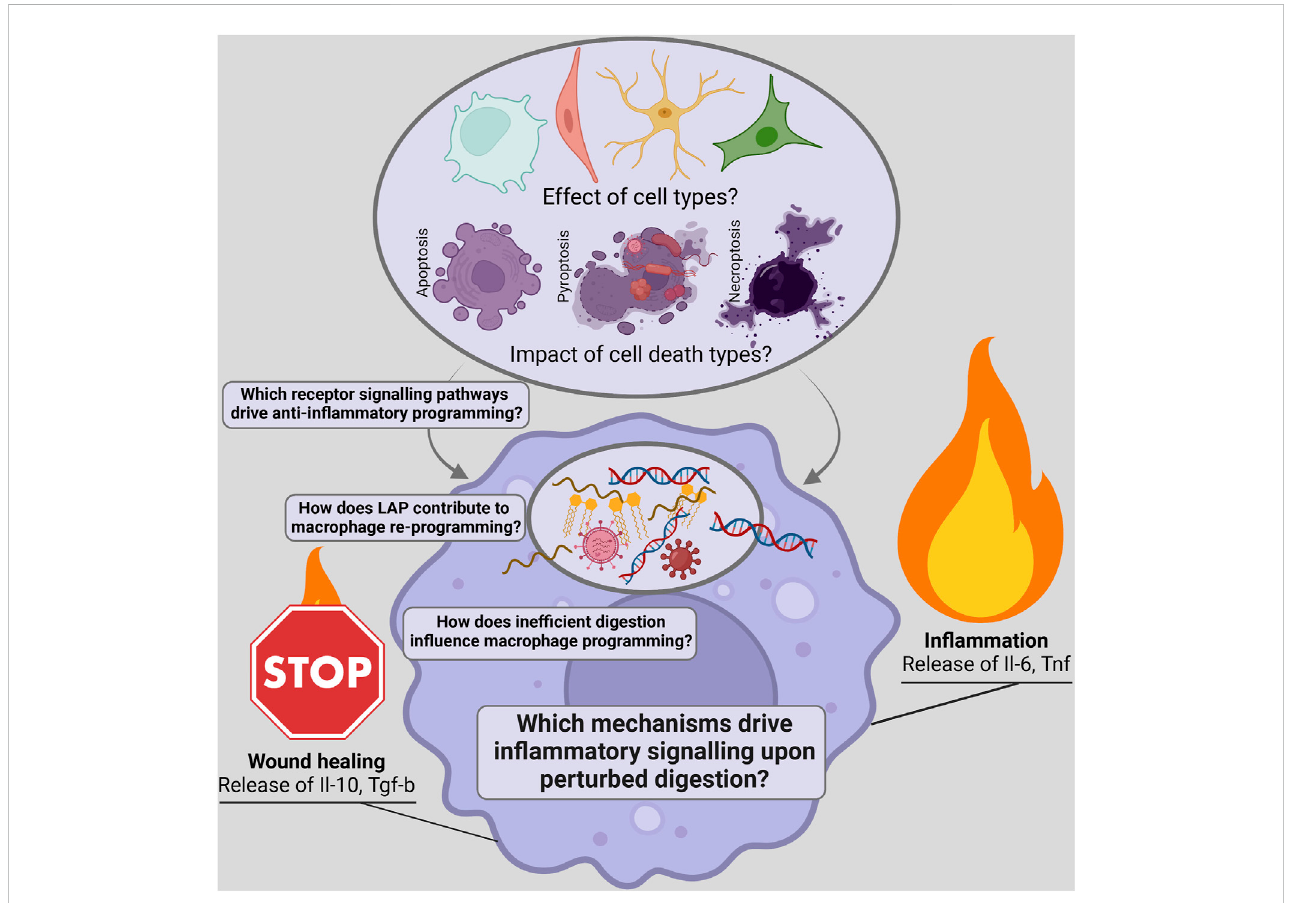
FIGURE 1 Scheme depicting open questions on the in fl uence of dead cargo and the identi fi cation of signalling pathways regulating the in fl ammatory potential of efferocytosis.